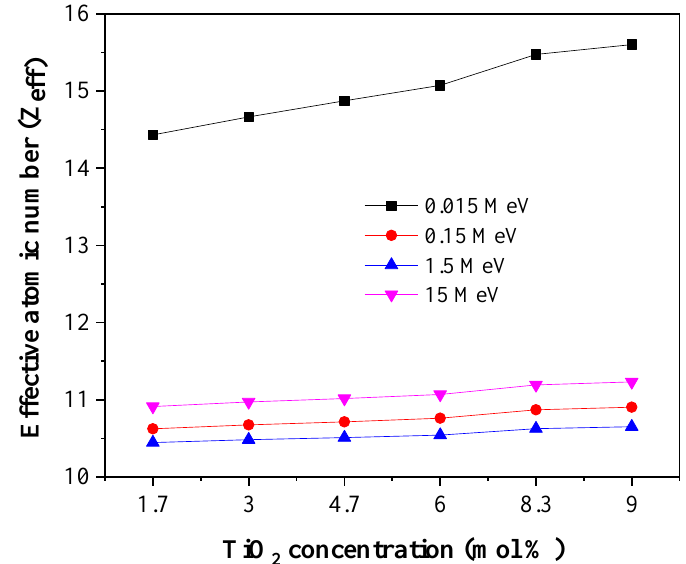
Figure 11. Change in Z eff at a fix four photon energies.